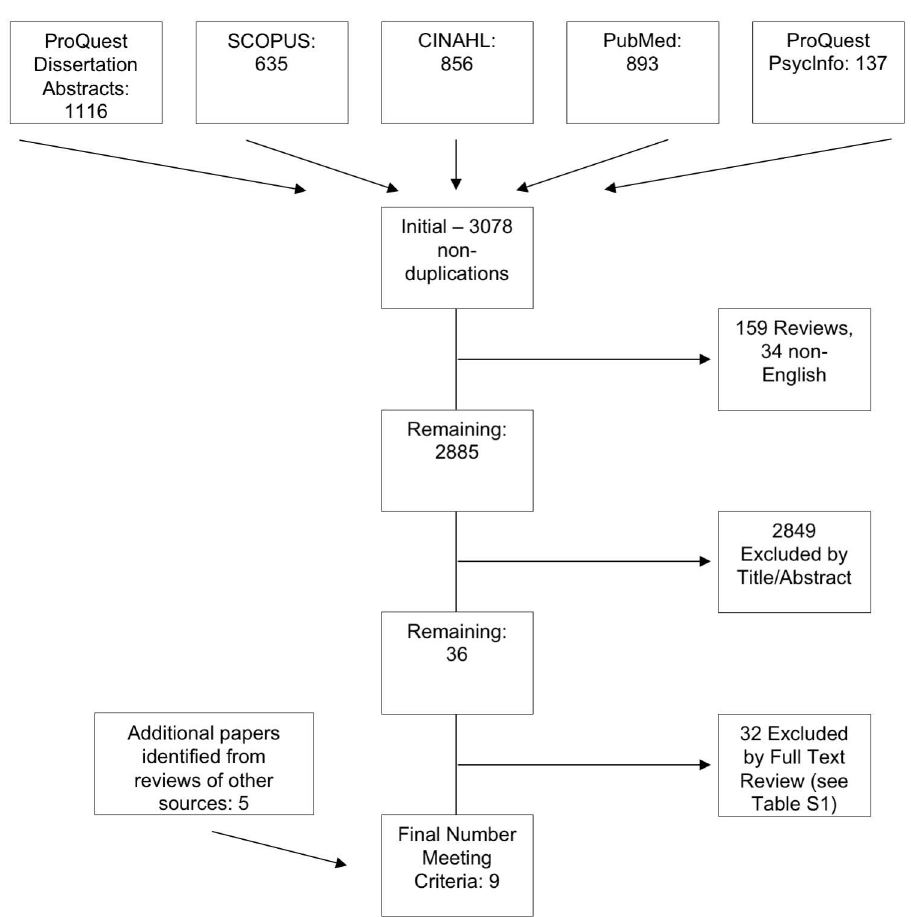
Fig 1. PRISMA flow diagram of the literature search selection